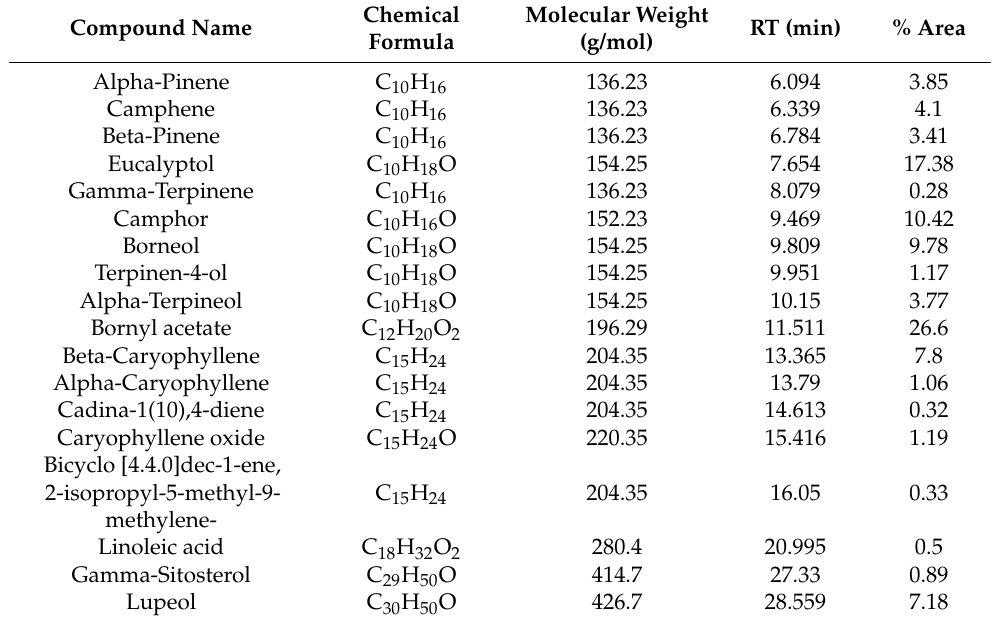
Table 2. GC-MS analysis of R. officinalis